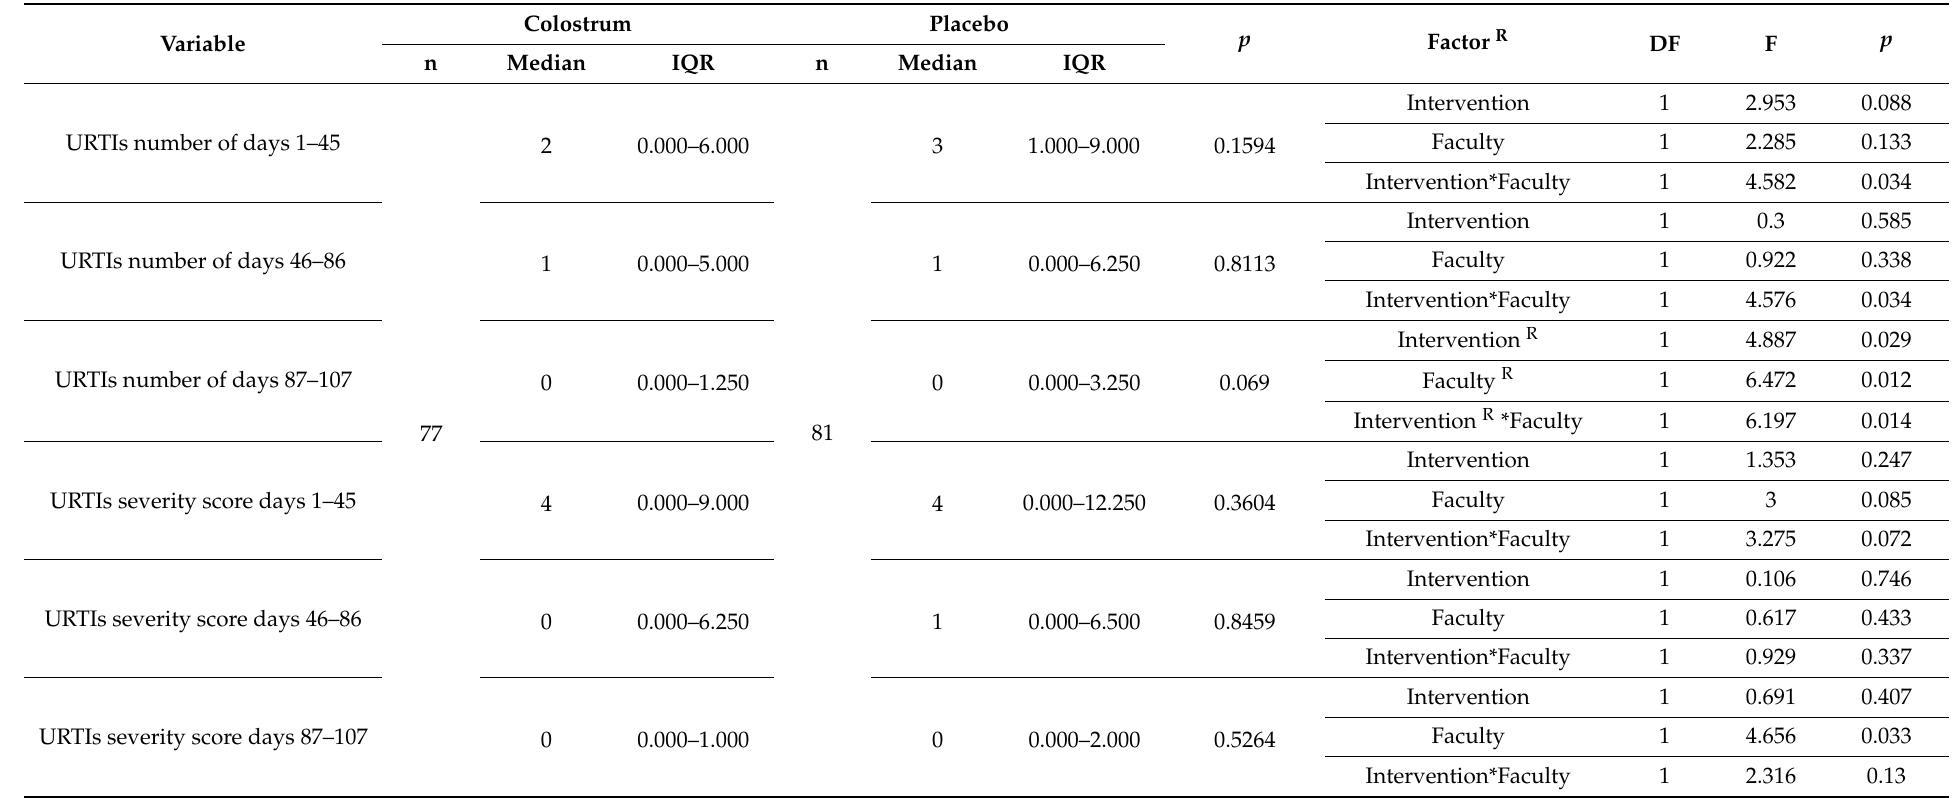
Table 2. The interaction between group allocation and faculty for URTIs symptoms days and severity as reported daily over three periods of the study. For two-way analysis data on URTIs incidence are